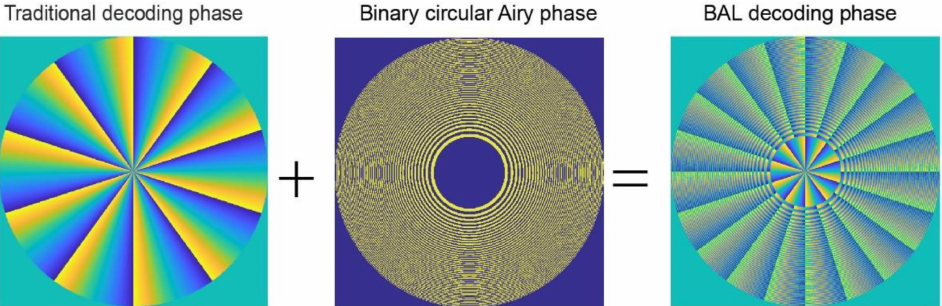
Figure 3. Comparison of traditional and BAL decoding phases.